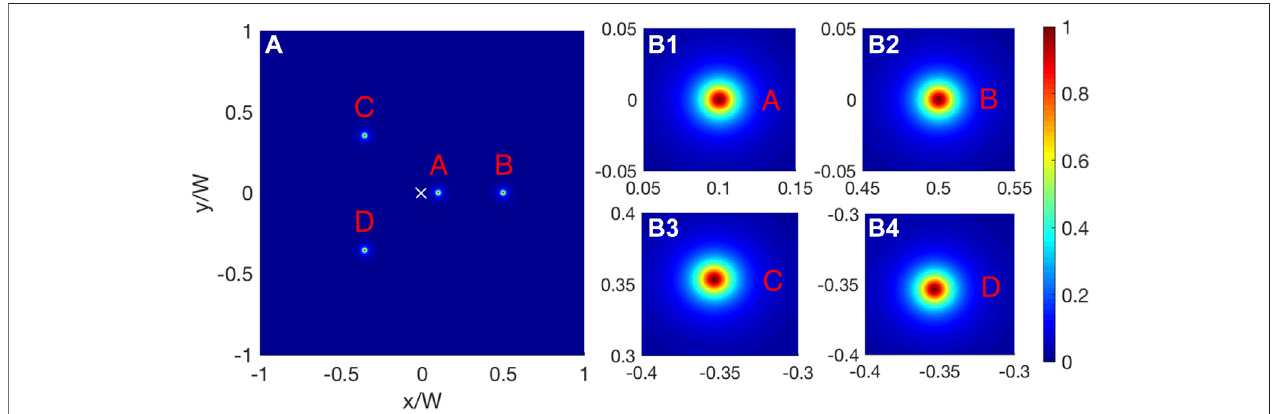
FIGURE2| Off-axisatomlocalization. (A) Off-axislocalizedpositionsA,B,C,andDwithrespectto( κ c , θ c 1 )=(0.1, π ),(0.5, π ),(0.5, π /4),(0.5, − π /4).Thewhitecross denotes the center of light beams. (B1 – B4) show the ampli fi ed images for the localized atomic positions, which have an off-axis feature. Here, Ω p 0 / Ω c10 = 0.01.